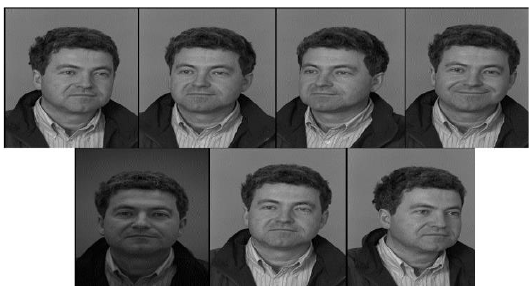
Figure 7. Faces from the ORL database